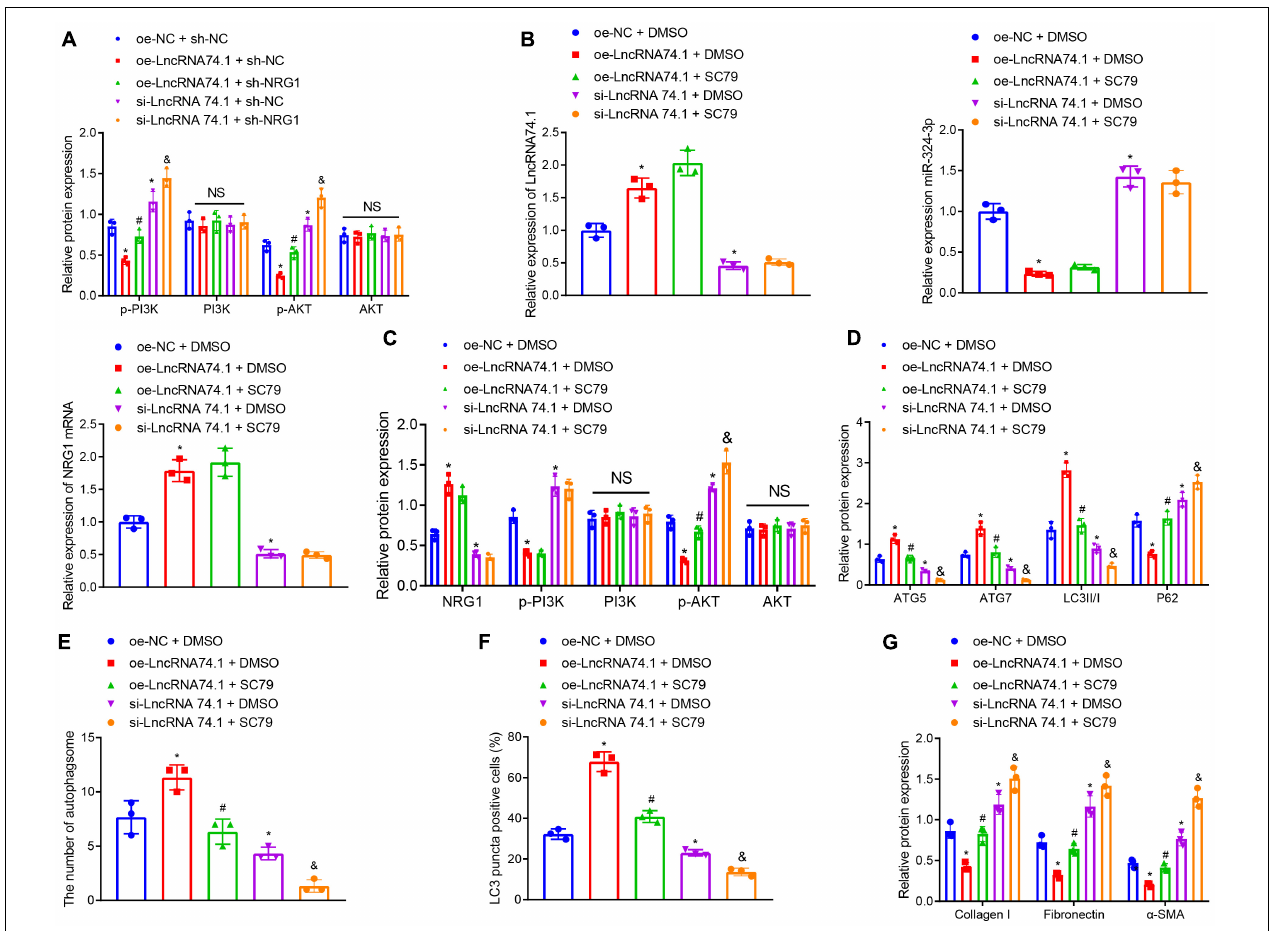
FIGURE 6 | LncRNA 74.1 inactivates the PI3K/AKT signaling pathway to promote autophagy and inhibit renal fibrosis. (A) Western blot results of PI3K, p-PI3K, AKT, and p-AKT expressions in HK-2 cells with different treatments; (B) RT-qPCR results of the expressions of lncRNA 74.1, miR-324-3p, and NRG1 mRNA in cells with different treatments; (C) Western blot results of NRG1, PI3K, p-PI3K, AKT, and p-AKT expressions in HK-2 cells with different treatments; (D) level of autophagy-related proteins by Western blot; (E) TEM observation of autophagosomes in HK-2 cells with different treatments; (F) proportion of LC3 positive cells in the HK-2 cells with different treatments by immunofluorescence assay; (G) protein levels of fibrosis markers in HK-2 cells with different treatments by Western blot; * p < 0.05 as compared with oe-NC + sh-NC or oe-NC + DMSO; # p < 0.05 as compared with oe-lncRNA 74.1 + sh-NC or oe-lncRNA 74.1 + DMSO; & p < 0.05